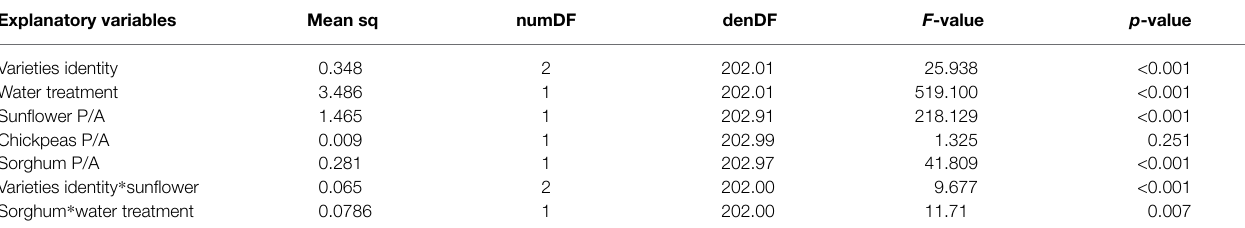
Relative Interaction Intensity Relative interaction index was affected by both variety identity ( F 2,163 = 9.51, p = 0.001) and plant identity ( F 1,163 = 43.36, p < 0.001). RII was positive for all varieties when they were grown with chickpeas or sorghum and it was the lowest in the presence of sunflower alone, irrespective of drought stress ( Figure 2 ). As mentioned above, different crop species showed varying ranges of tolerance to drought stress in our experiment (in terms